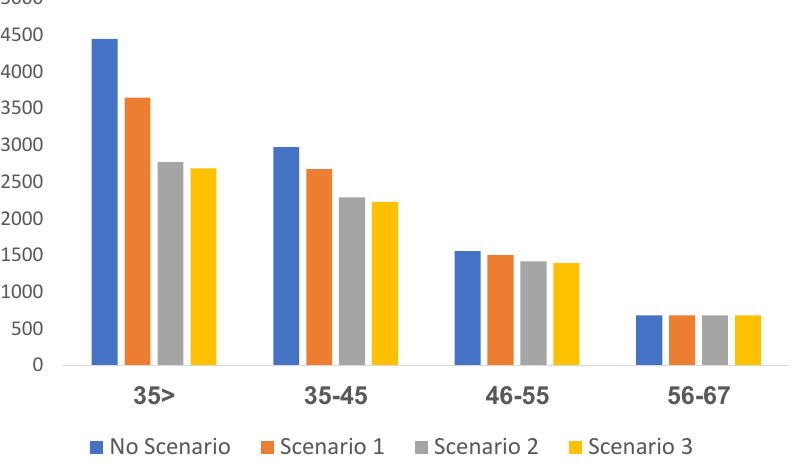
Table 2. Expected Monthly Funded Benefits (USD).